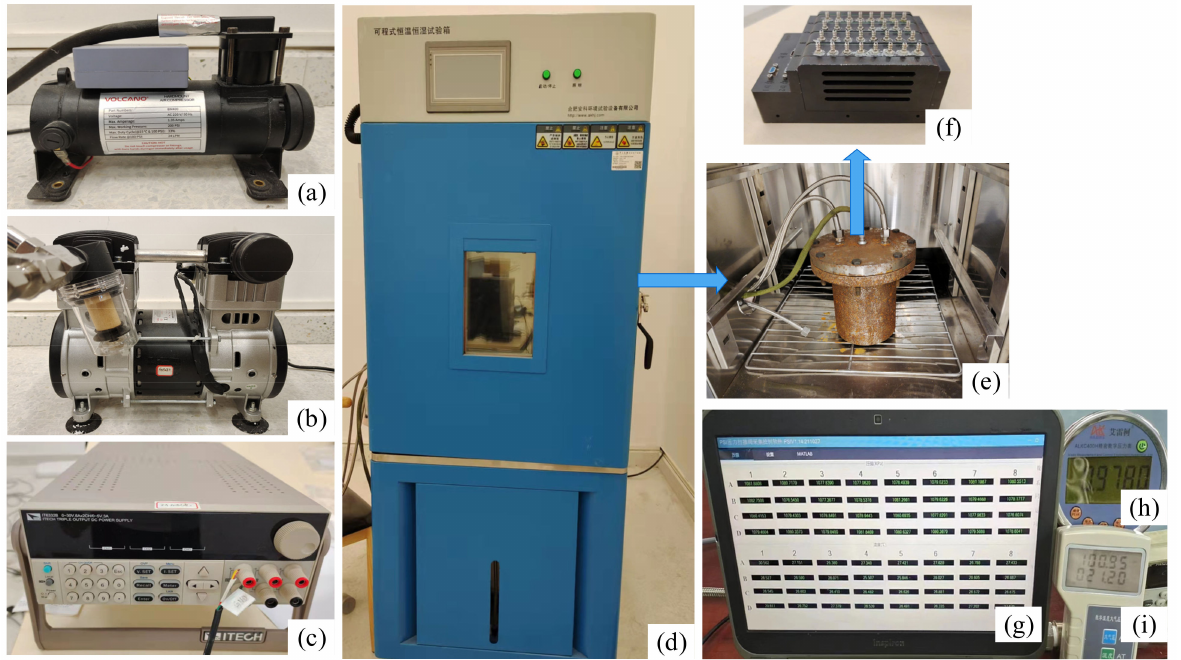
Figure 5. Calibration experiment system of multi-channel pressure scanner: ( a ) BM400 air com- pressor, ( b ) SY-3000H vacuum pump, ( c ) ITECH IT6332B DC regulated power supply, ( d ) thermo- statically and humidity-controlled test chamber, ( e ) sealing device, ( f ) 32-channel pressure scanner, ( g ) test computer, ( h ) ALKC400H precision digital pressure gauge, ( i ) digital temperature–atmosphere pressure